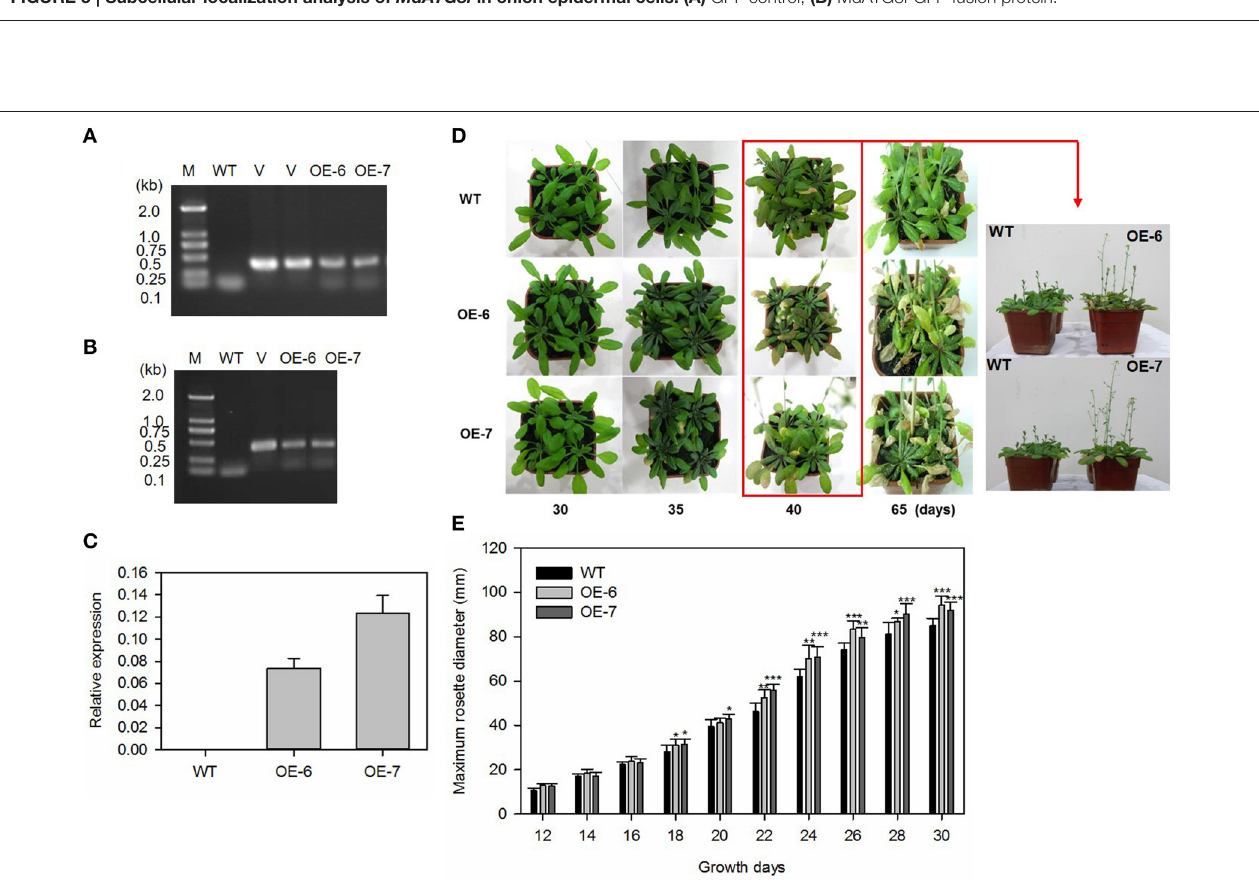
FIGURE 6 | Heterologous expression of MdATG8i in Arabidopsis and growth phenotype. (A) PCR with gDNA; (B) PCR with cDNA; Lanes M, molecular marker DL2000; V, positive vector containing pGWB406- MdATG8i plasmid; WT, non-transformed wild-type; OE-6 and -7, MdATG8i -transgenic lines; (C) qRT-PCR analysis of MdATG8i transcripts in Arabidopsis lines OE-6 and OE-7; (D) Growth phenotype comparison of WT and transgenic lines under LD photoperiod; (E) Growth for rosettes from WT or transgenic lines under SD photoperiod; Data are means ± SD of 20 replicates. * , ** or *** indicates the statistically significant differences determined by Student’s t -tests at P < 0.05, P < 0.01, or P < 0.001, respectively.